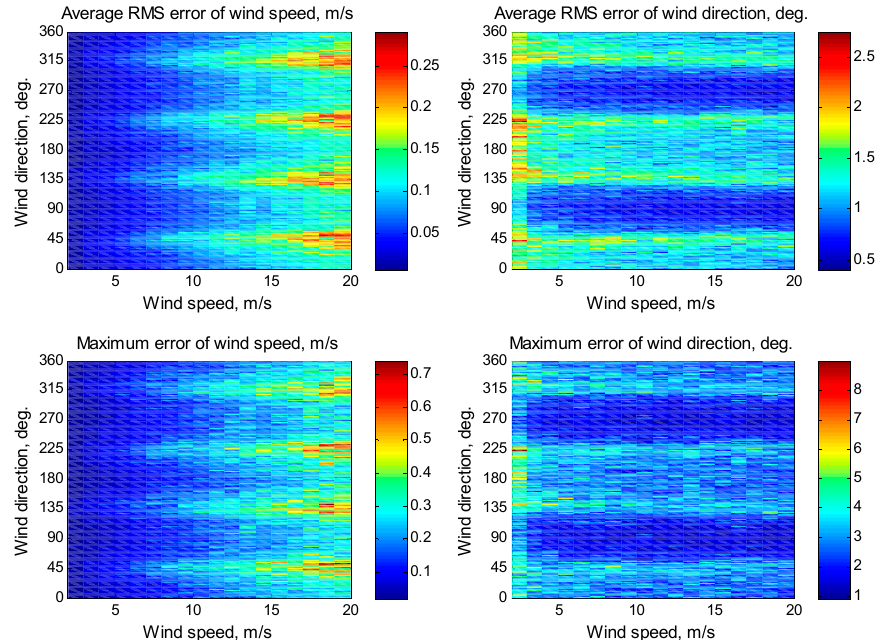
Figure 12. Simulation results for the mounting angle of a beam axis in the horizontal plane of 30 ◦ with the assumption of 0.2 dB instrumental noise at wind speeds of 2–20 m/s for the incidence angle of 45 ◦ with 1565 averaged NRCS samples for each azimuthal angle.